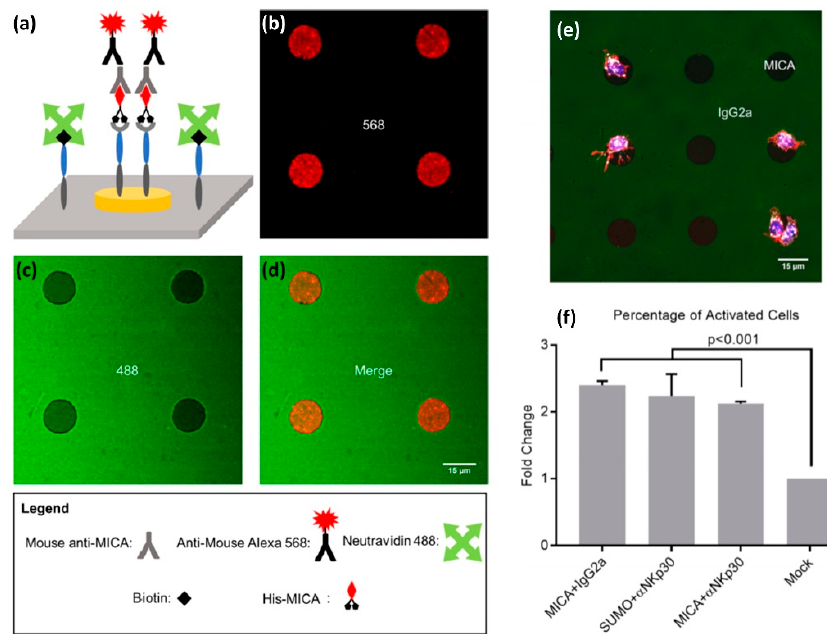
Figure 6. Site-selective functionalization of a photolithographic pattern with two ligands for NK cell receptors. ( a ) Orthogonal functionalization of TiO2/Au surface ( b ) Fluorescent image of Au disks functionalized with His-MICA, and stained with mouse anti-MICA and anti-mouse Alexa 568. ( c ) Fluorescent image of TiO 2 background functionalized with Oregon Green 488-labeled NeutrAvidin. ( d ) Merging images ( c , d ) confirm the site-selective functionalization. ( e ) Primary NK cells stained with Alexa Fluor 555 phalloidin to visualize the cytoskeleton, DAPI for nuclei, and APC-labeled anti-CD107a as a marker for NK cell activation ( f ) Percentage of CD107a positive cells on various regions of the substrates. Analysis of variance and Tukey’s post hoc test were performed to assess the significant changes in behavior. The results were considered significant for p < 0.05. p -Values are also reported for comparisons of interest. Reprinted with permission from Reference [50].